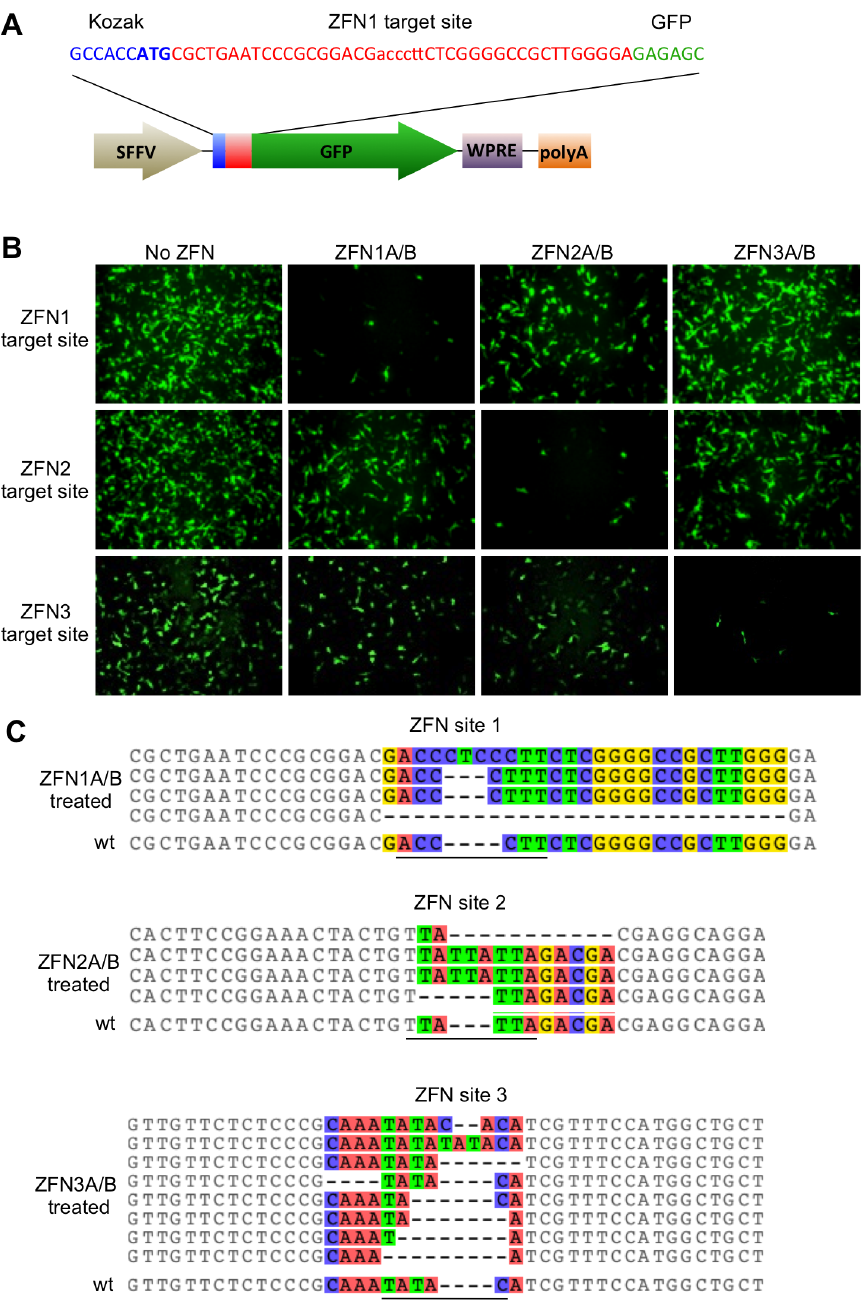
Figure 2. HBV-ZFN activity in mammalian cells. ( a ) HBV-ZFN target site/GFP reporter plasmid containing a ZFN target site (red) placed immediately after the GFP start codon (blue) and preceding the in-frame GFP ORF (green). The HBV-ZFN spacer is shown in lower case. ( b ) ZFN reporter constructs and expression plasmids for ZFN pairs 1–3 were transfected into HEK 293T cells. GFP expression was visualized at 72 hours post transfection. ( c ) ZFN-mediated target site disruptions within reporter constructs were amplified by PCR from the HEK 293T cells that had been transfected with ZFN-expressing plasmids as indicated. Indels found at each ZFN site are aligned with the wild type target sequence (wt) and nucleotides with differences in at least one sequence are shown in color. The spacer regions are underlined. GFP – green fluorescent protein; SFFV – spleen focus-forming virus promoter; WPRE – woodchuck hepatitis post-transcriptional regulatory element; polyA – polyadenylation signal; wt – wild type; ZFN – zinc finger nuclease. doi:10.1371/journal.pone.0097579.g002 performed a sensitive droplet digital PCR assay (ddPCR) [38] to gene RPP30 to account for experimental variation. Removal of detect HBV levels in the cellular extracts and cell culture media dox resulted in a 30-fold and 323-fold rise in HBV levels in cells (Figure 6B–C). Cellular HBV levels were normalized to the cell and cell supernatants, respectively. We chose to test only ZFN pair numbers as determined by the quantification of the housekeeping 3 since it had produced high levels of targeted mutagenesis without